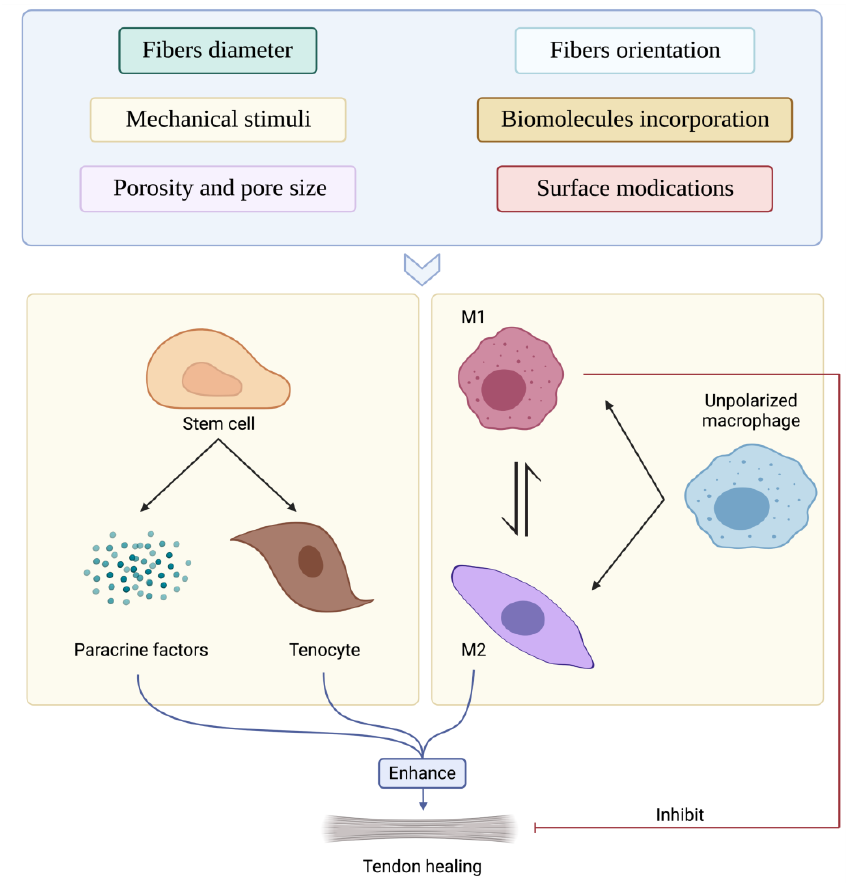
Figure 5. Effects of electrospun scaffolds-based immunoregenerative strategies on macrophage polarization and stem cell immunomodulation.